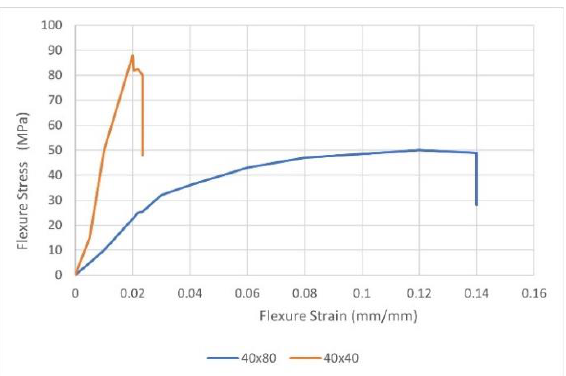
Figure 9. Flexure stress vs. flexure strain graph of case 4, 40 × 80 sample pieces, compared to case 5, 40 × 40 sample pieces.